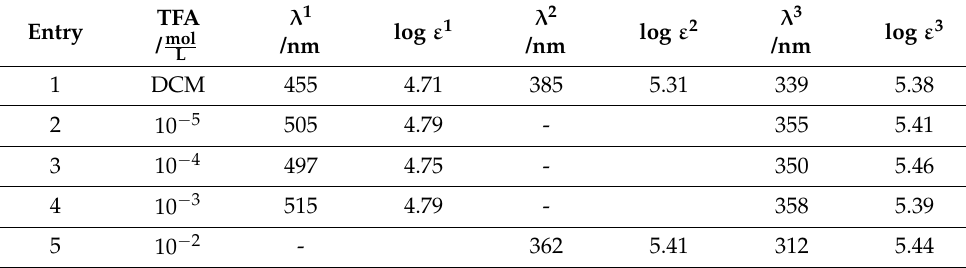
Figure 1. Optical spectra of 3 in dichloromethane and in the presence of acid . Table 1. Optical data of 3 in dichloromethane and with TFA. Table 1. Optical data of 3 in dichloromethane and with TFA.